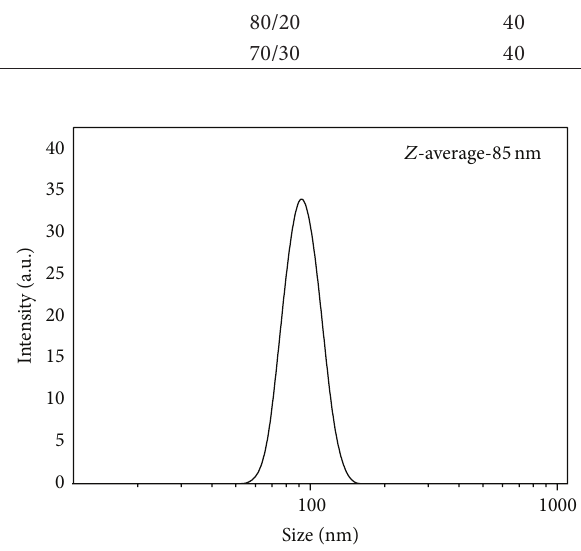
Figure 3: The particle size distribution of NBG measured by